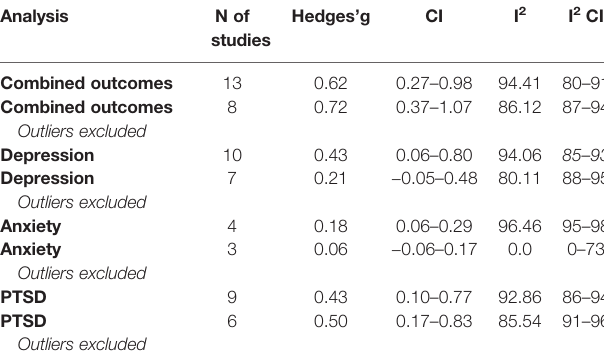
TABLE 7 | Summary of the